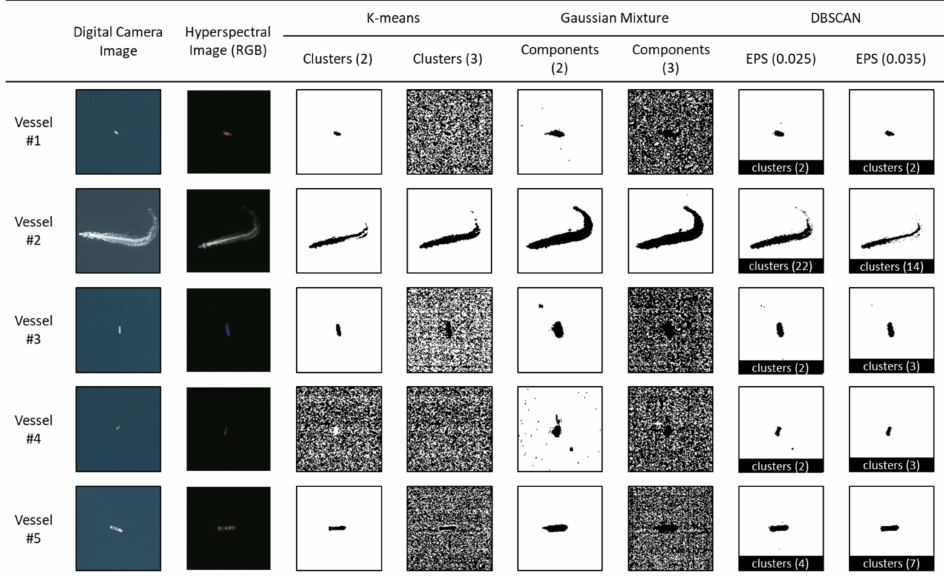
Figure 5. Small vessel detection performance analysis using clustering algorithms. The detection performance for five target vessels in the sea was analyzed using K-means, Gaussian Mixture, and DBSCAN as representative clustering algorithms in machine learning. Target detection refers to the detection of pixels of maritime objects excluding seawater clusters. Ultra-high-resolution DMC images and hyperspectral RGB images were added to facilitate intuitive viewing and checking of the detection results for each